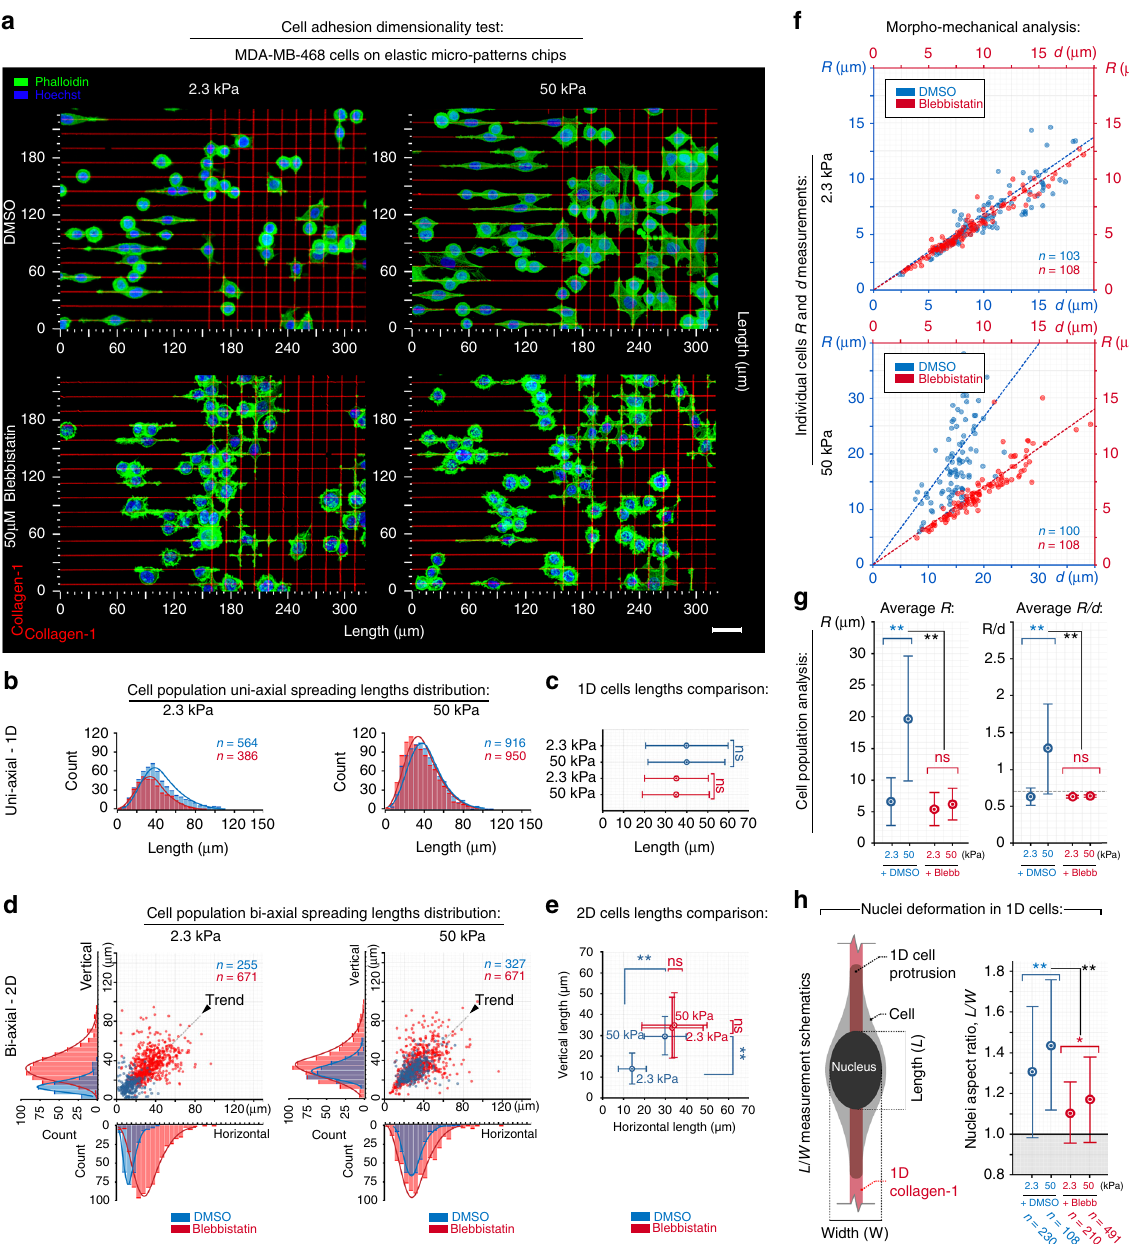
Fig. 2 ECM dimensionality and stiffness in fl uence guidance sensing. a MDA-MB-468 breast carcinoma cells sensing and protruding along uniaxial collagen lines that mimic aligned fi bers and biaxial cues to mimic fi ber networks (left and right halves of each micrograph, respectively; 3D reconstructions) on soft (2.3 kPa) and stiff (50 kPa) substrates under control (DMSO, Supplementary Movies 1,2,3) and blebbistatin-treated conditions. Blebbistatin-treated cells display a dendritic protrusion phenotype in response to uniaxial (Supplementary Movie 4) and biaxial (Supplementary Movie 5) cues on both soft and stiff substrates, suggesting the presence of a bimodal response to guidance cues that depends on cell traction stress magnitudes. b , c Morphometric analysis of cells on soft and stiff uniaxial guidance cues for control conditions (blue) and blebbistatin treatment (red). For both conditions, uniaxial collagen lines induce a robust guidance response with no signi fi cant differences in cell protrusion between soft and stiff substrates. All corresponding n values in c are shown in b . d , e Morphometric analysis of cells interacting with biaxial guidance cues in control (blue) and blebbistatin-treated conditions (red), with signi fi cantly greater protrusion on stiff versus soft substrates for control cells. Blebbistatin-treated cells display no detectable difference in their biaxial guidance response on soft and stiff substrates. All corresponding n values in e are shown on d . f , g Morpho-mechanical analysis of cells of soft and stiff substrates showing signi fi cantly higher values for both R and R / d metrics in response to stiff substrates, representative of higher cell traction forces in response to stiff substrates. In contrast, soft substrates or inhibition of contractile forces result in low R values and mean R / d values near the threshold for elastic cell behavior. All corresponding n values and individual data points in g are shown in f . h Nuclei deformation, where lateral compression results from cell tension alignment, as a reference for contractile force magnitude. Scale bar in a — 15 µ m. Corresponding n values are shown on the plots. Number of replicates (independent experiments) for all measurements N = 4. Data in c , e , g , h are mean ± s.d.; ns: no signi fi cant difference between groups; * p < 0.05, ** p < 0.001